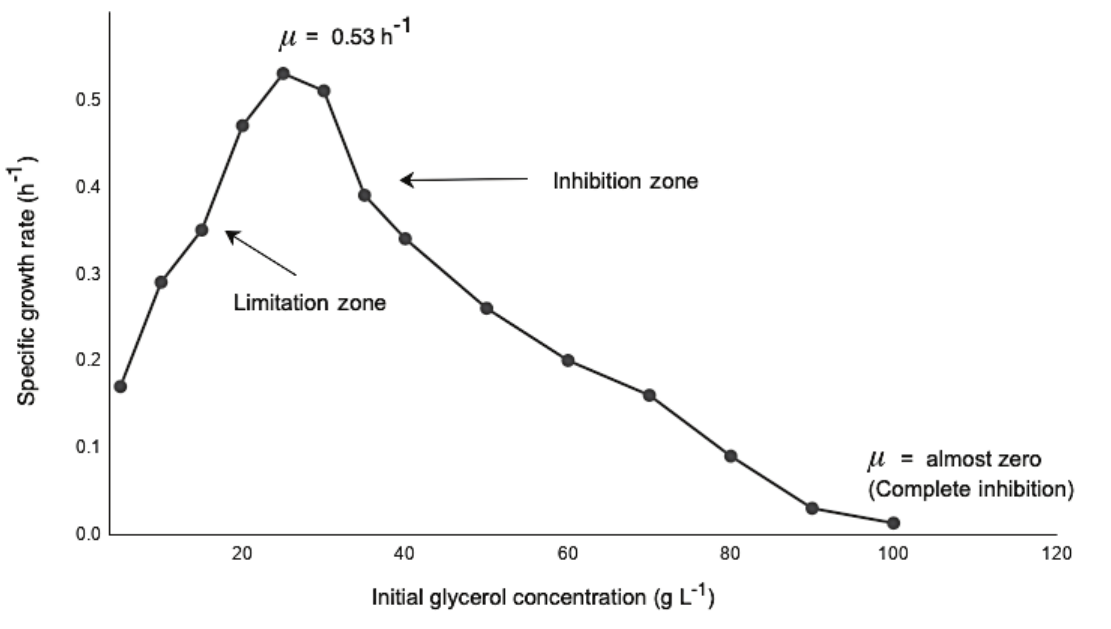
Fig. 1 – Effect of increasing initial glycerol concentration on growth of C. necator